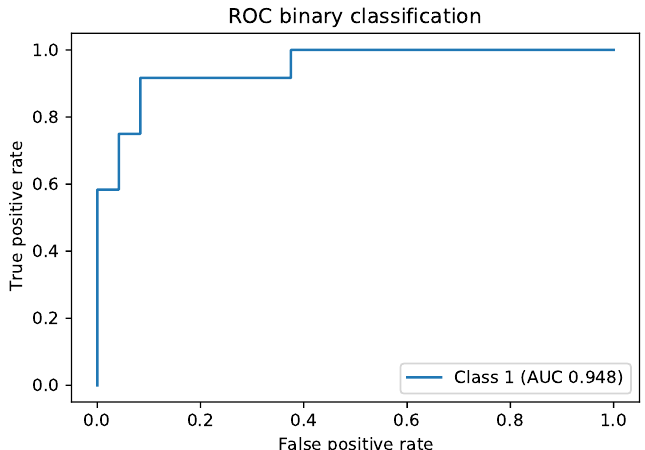
Figure 7. ROC curve for the binary classification for the fine-tuned ensemble.